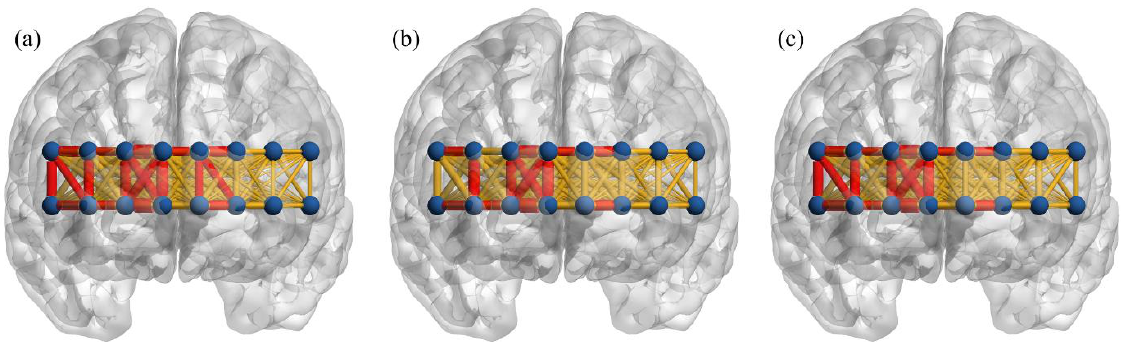
Figure 2. Averaged functional connectivity across all subjects in three conditions; ( a ) vanilla baseline, ( b ) simple GNG, and ( c ) emotional GNG. Red edge: connections that have connectivity greater than 0.5, yellow edge: other connections.